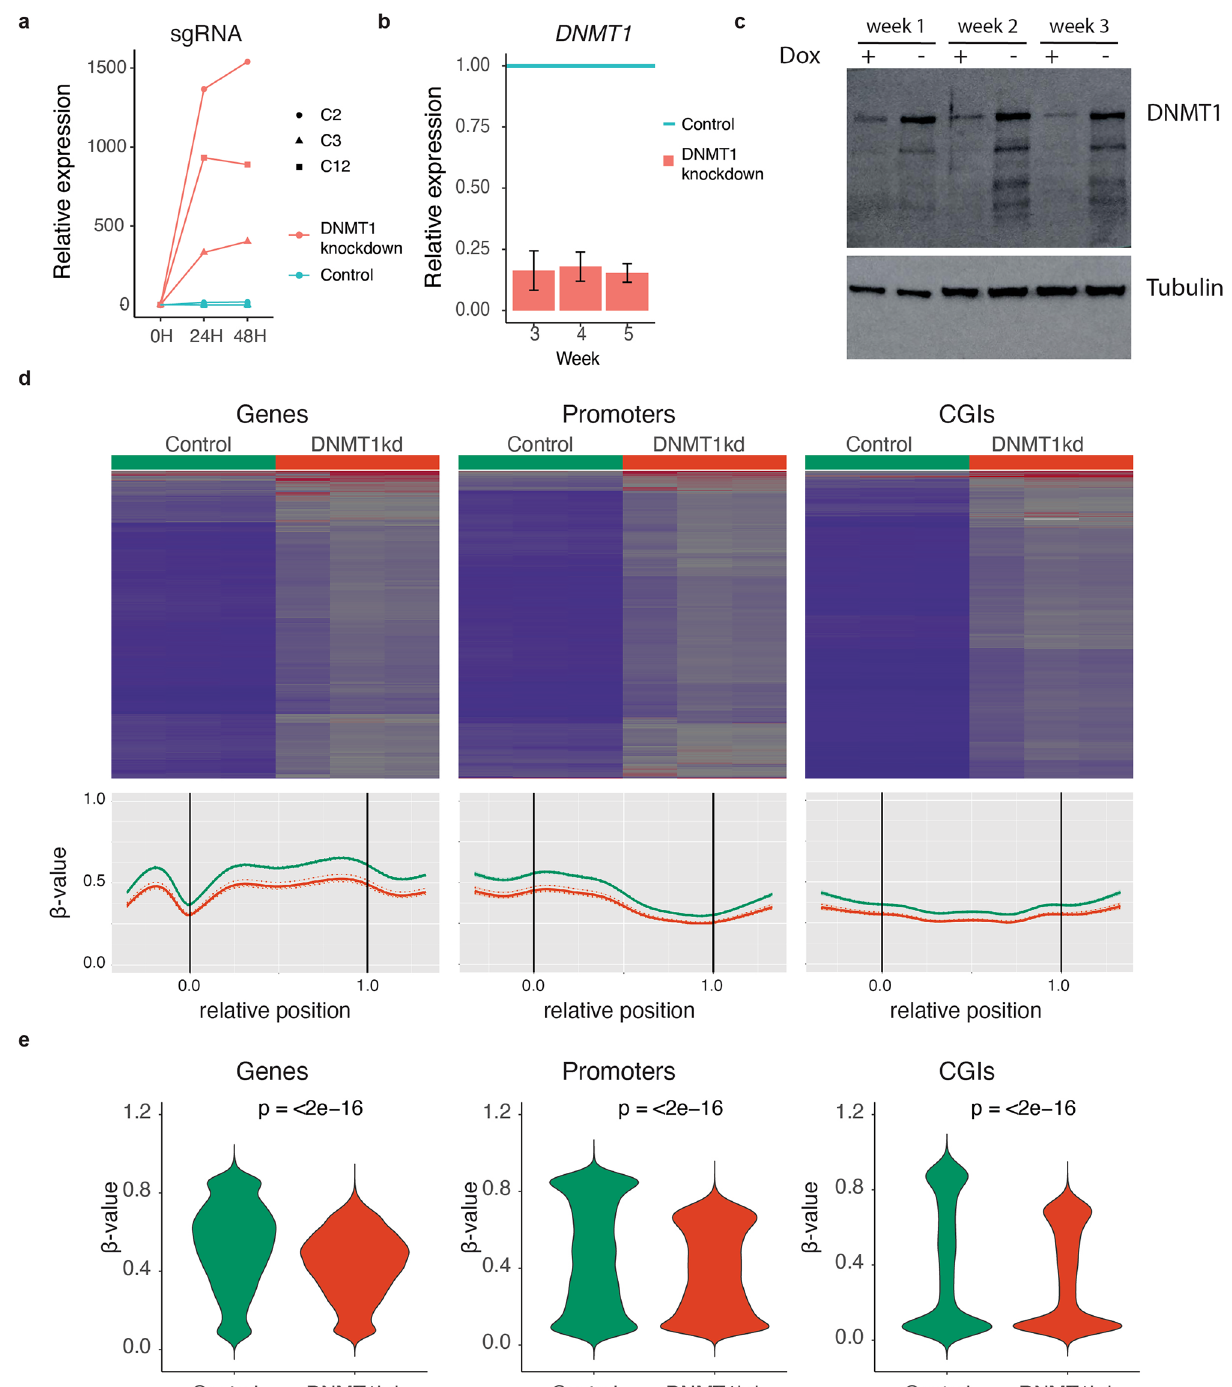
Figure 1. Characterization of DNMT1 knockdown cells ( a ) Relative increase in doxycycline-inducible sgRNA expression upon 24 h and 48 h hours of treatment with doxycycline. ( b ) Relative DNMT1 expression levels upon doxycycline treatment of DNMT1 knockdown cells. n = 4 per time point. ( c ) Western blot images of DNMT1 protein expression levels upon prolonged doxycycline treatment of DNMT1 knockdown cells for the indicated time points. ( d ) EPIC DNA methylation array analysis of DNMT1 knockdown cells cultured with or without doxycycline for 6 weeks. Top panels: heatmaps with methylation values for control (n = 3) and DNMT1 knockdown (n = 3) cells. Lower panels: Regional methylation profiles (composite plots) according to sample groups. DNMT1 knockdown cells consistently show reduced methylation density represented by lower β-values. For each region in the corresponding region type, relative coordinates of 0 and 1 correspond to the start and end coordinates of that region respectively. Coordinates smaller than 0 and greater than 1 denote flanking regions normalized by region length. Horizontal lines indicate region boundaries. ( e ) Violin plots of the β-values for genes, promoters and CGIs. Statistical test: paired Wilcoxon signed-rank